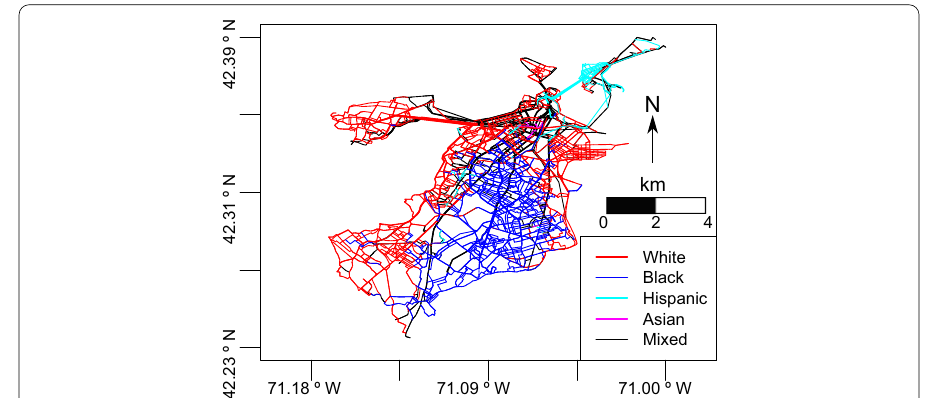
Fig. 3 Representation of the street network, with edges colored based on their group demand and width representing their total demand. If more than a group has a demand higher than expected by chance, it is considered as Mixed. Notice that while there is a clear correlation with neighborhoods, most central routes have a mixed usage, showing that they are heavily used by multiple